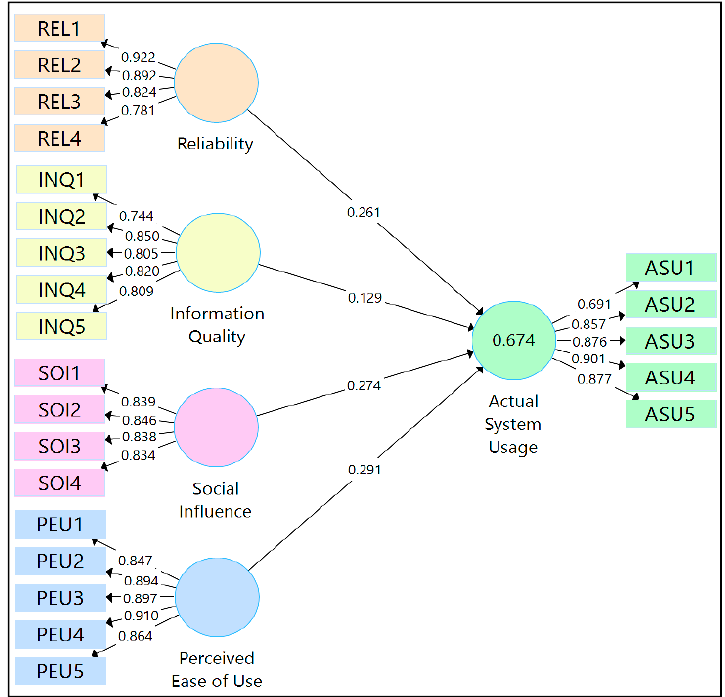
Appl. Sci. 2021 , 11 , 4176 Figure 3. Structural Path Model Coefficient. Figure 3. Structural Path Model Coefficient.